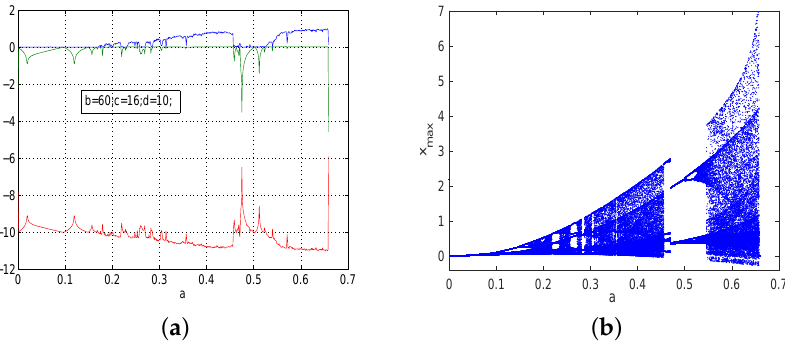
Figure 3. The Lyapunov exponents spectrum and the bifurcation diagram of system (1) with ( b , c , d ) = ( 60,16,10 ) and 0 < a < 0.66 at the initial values ( 0.01,0.01,0.01 ) T : ( a ) Lyapunov exponents; ( b ) bifurcation